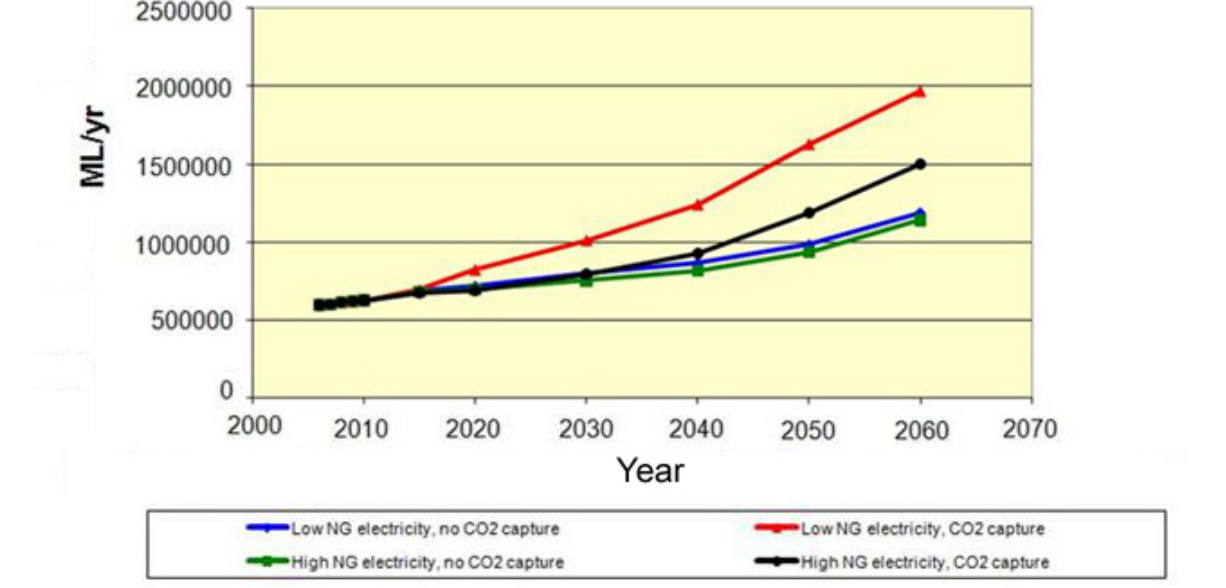
Fig. 9 . Projected water consumption for power generation in Texas with low and high natural gas use and with and without capture of carbon dioxide (Webber et al.